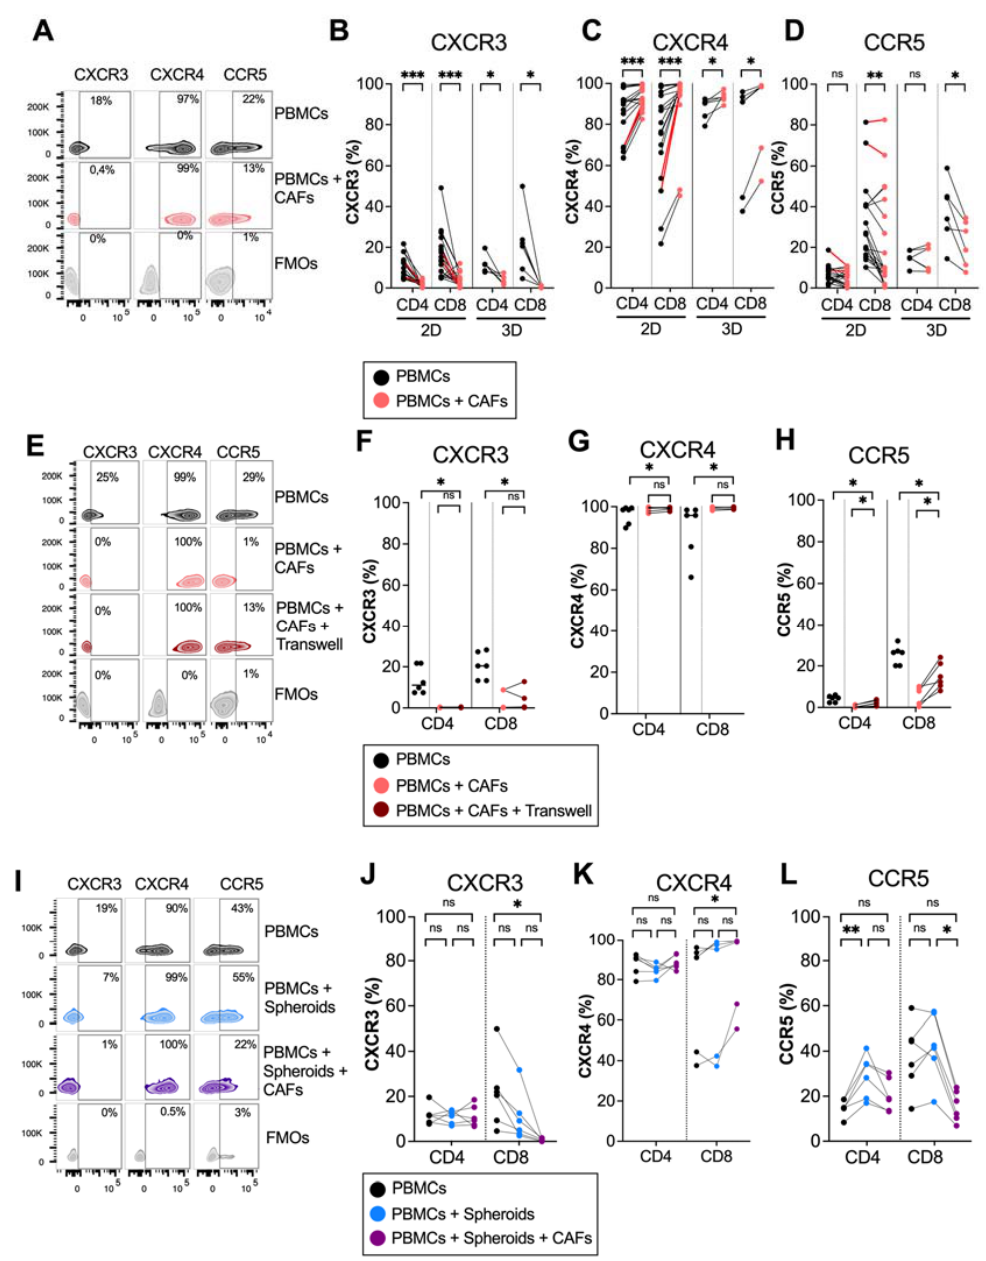
Figure 1. CAFs modulate chemokine receptor expression on T cells in 2D and 3D models. PBMCs were cocultured in the absence (black dots) or presence of CAFs (light red dots) in direct cocultures or in indirect transwell cocultures for 5 days. ( A ) Representative zebra plots showing the gating strategy in ( B – D ). ( B – D ) Frequency of ( B ) CXCR3, ( C ) CXCR4 and ( D ) CCR5 expression in CD4 + and CD8 + T cells in 2D ( n = 21) and 3D models ( n = 6) . ( E ) Representative zebra plots showing the gating strategy in ( F – H ). ( F – H ) Frequency of ( F ) CXCR3, ( G ) CXCR4 and ( H ) CCR5 expression in CD4 + and CD8 + T cells in direct cocultures (light red dots) or indirect transwell cultures (dark red dots) ( n = 6). ( I ) Representative zebra plots showing the gating strategy in ( J – L ). ( J – L ) Frequency of ( J ) CXCR3 ( K ) CXCR4 and ( L ) CCR5 expression in CD4 + and CD8 + T cells in 3D models in the absence of spheroids and CAFs (black dots), in the presence of spheroids (blue dots) or the presence of spheroids and CAFs (purple dots) (n = 6). Dots and lines show paired samples. ( B – H ) Wilcoxon signed-rank test was used to detect statistically significant differences between paired samples. ( J–L ) Friedman’s test was used to detect statistically significant differences. ns, not significant. * p < 0.05, ** p < 0.01, *** p <